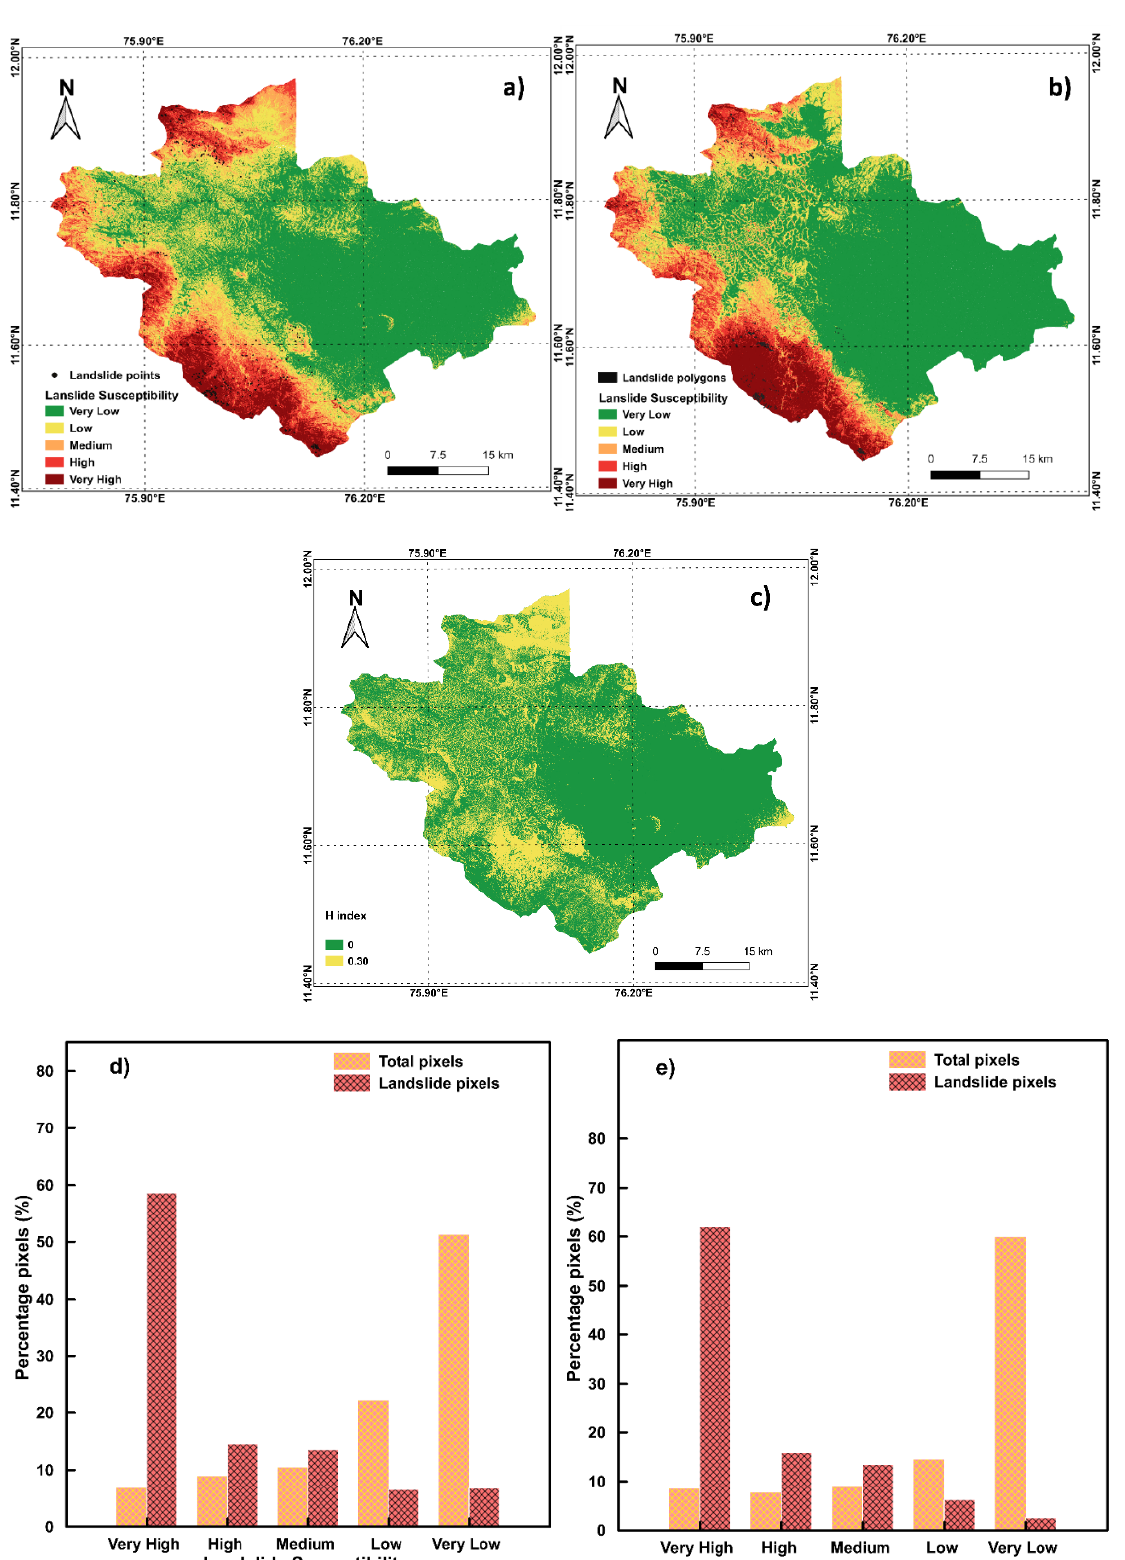
Figure 8. Details of landslide susceptibility maps prepared using LR algorithm: ( a ) using point data, ( b ) using polygon data, ( c ) H-index plot, ( d ) percentage distribution of pixels using point data, and ( e ) percentage distribution of pixels using polygon data.